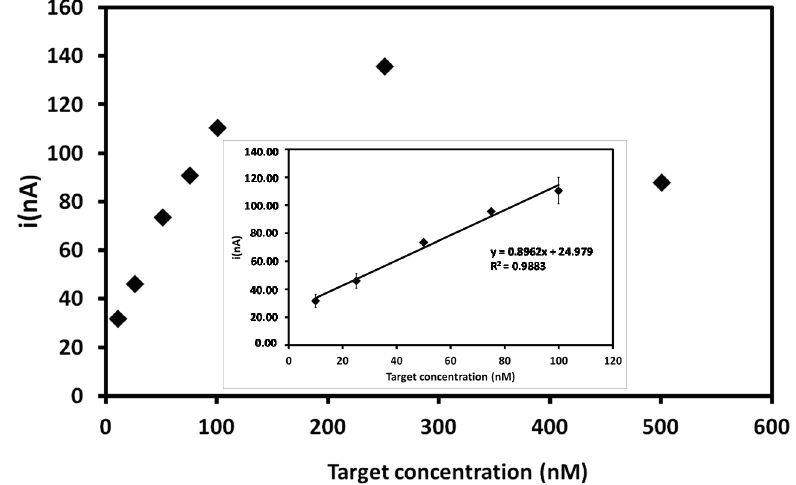
Figure 3. Current signals obtained for different DENV-3 target sequence concentrations after hybridization with probe-modified PGEs. Inset: Related calibration graph at a concentration range of 10–100 nM for the target sequence. Experimental conditions: Scanning potential range between +0.5 V and +1.2 V and scan rate of 0.05 V/s.